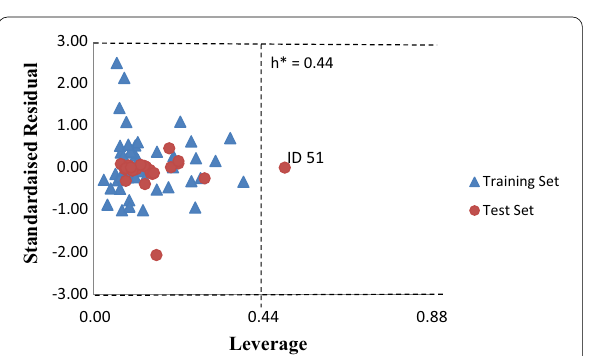
Fig. 2 The model applicable